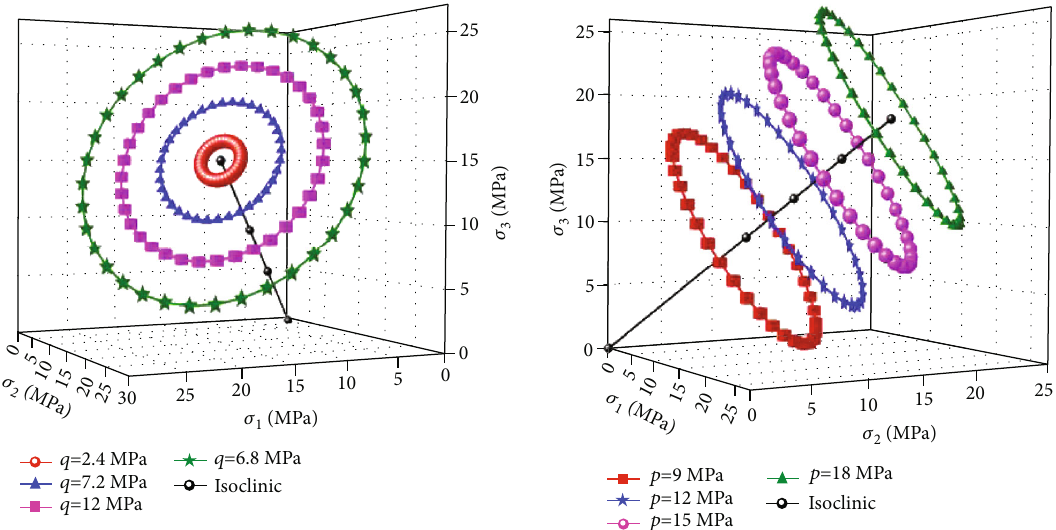
(a) The stress space diagram under the constant deviatoric stress (b) The stress space diagram under the constant spherical stress Figure 1: The distribution of stress and